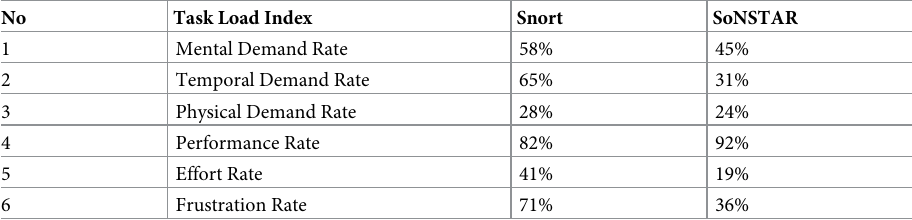
Table 6. NASA-Task Load Index results.